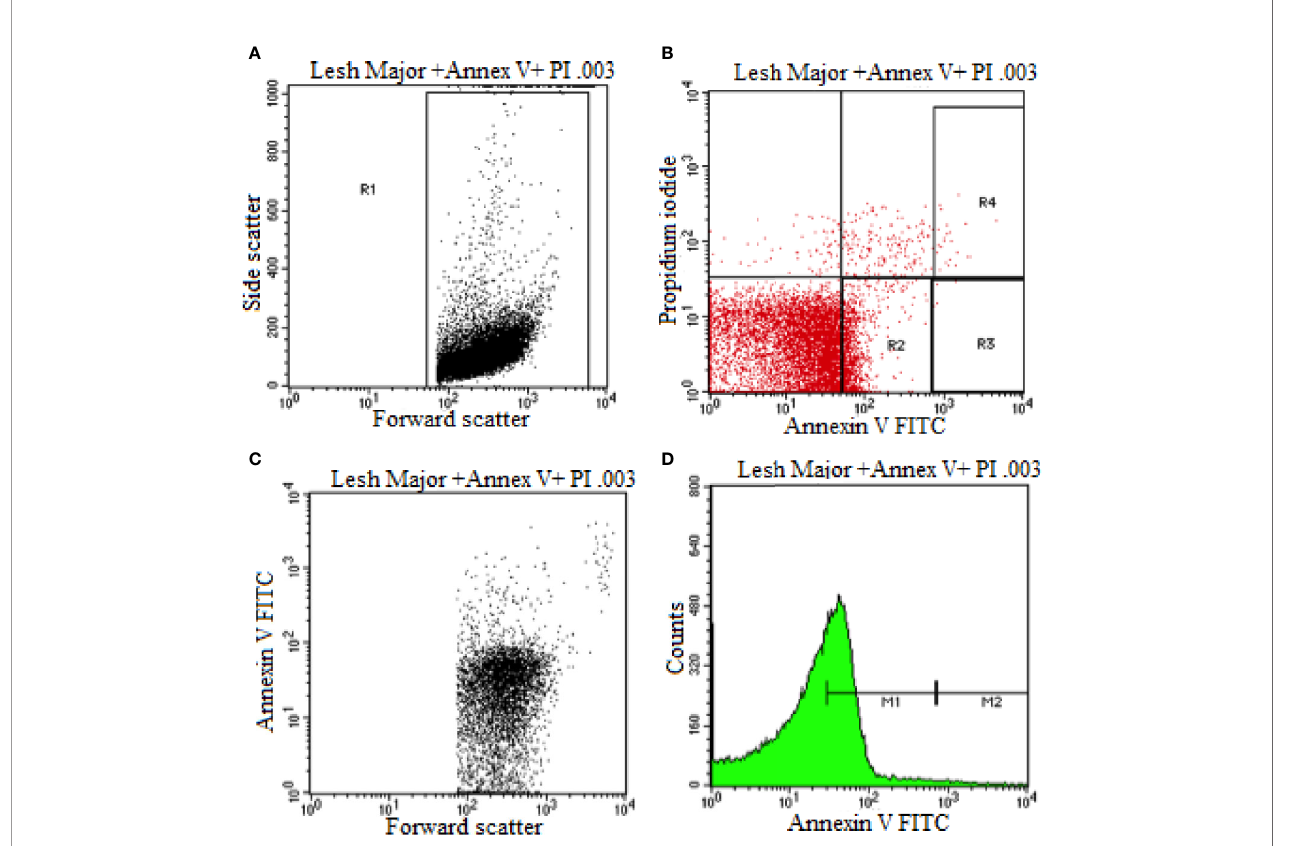
FIGURE 3 | Flow cytometry analysis of promastigotes following treatment with HA and after labeling with annexin-v and pi (untreated Leishmania major promastigote). (A) Dot Plot analysis of gated L. Major (R1) showing its size (Forward Scatter) and internal granularity (Side Scatter). (B) Dot Plot analysis of cellular apoptotic (Annexin V) and necrotic cells (Propidium Iodide) where L. Major expresses early cellular apoptosis (R2) and necrotic and apoptotic cells (R4). (C) Dot Plot analysis of L. Major being expressed in size (Forward Scatter) and cellular apoptosis (Annexin V). (D) Histogram plot analysis of L. Major showing low apoptotic cell expression (M1) and high apoptotic cell